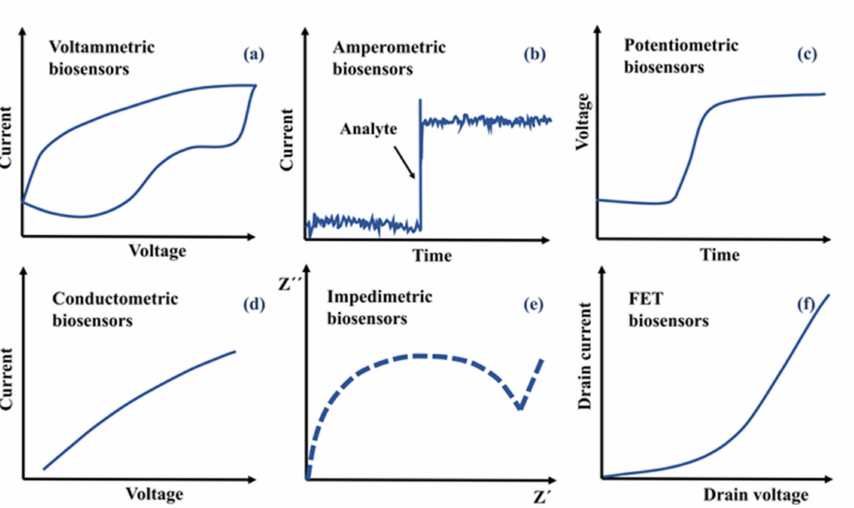
Figure 8. Typical signals to be measured from the different electrochemical biosensors (for any detector, support electrolyte and redox molecule used). When an analyte is detected, ( a ) the char- acteristic I-V curve for a voltammetric biosensor, ( b ) I-t for an amperometric biosensor, ( c ) V-t for a potentiometric biosensor, ( d ) I-V for a conductometric biosensor, ( e ) Z”-Z’ for an impedimetric biosensor or ( f ) drain current-drain voltage for a FET biosensor is